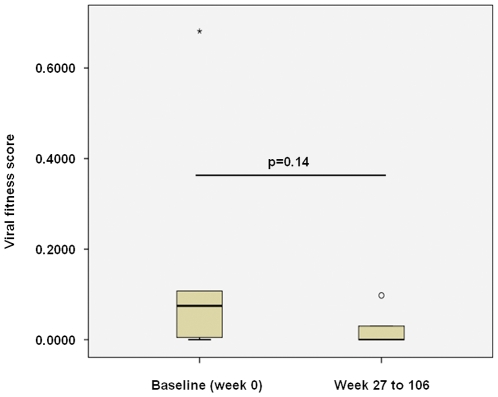
Decreasing fitness over time observed following analysis of paired isolates obtained from acute HIV-1 infection subjects, measured using QPCR.Relative viral fitness scores were calculated for isolates obtained from PULSE subjects and represented on a box-plot. Only subjects from whom a Baseline isolate and at least one additional isolate (Week 27 to 106) were obtained were included in the analysis (n = 6). Where multiple isolates from additional time-points were obtained, the average of the combined viral fitness scores was used. Shown are viral fitness scores calculated at the final time-point tested (158 h; exception was 3.13 which was at 72 h) ex vivo for paired isolates obtained from 6 PULSE subjects. The box represents the middle 50% of values for the data set, the solid line indicates the median value. The vertical ‘whiskers’ extending from the box respectively indicate the lowest and highest observed values. The open circle represents an outlier; the asterisk represents an extreme outlier. The significance of the observed changes in viral fitness over time is shown (p = 0.14), calculated using a signed rank test.